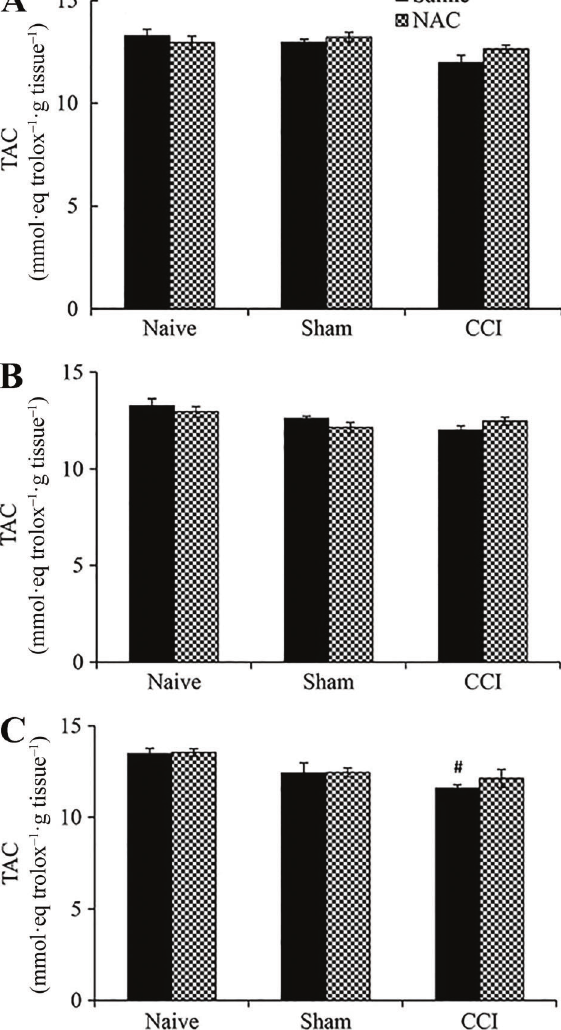
Figure 2. Ascorbic acid levels in the spinal cord of chronic constriction injury (CCI) rats treated with N-acetylcysteine (NAC; 150 mg (cid:1) kg – 1 (cid:1) day – 1 ) or saline administered intraperitoneally for 1 ( A ), 3 ( B ), and 7 ( C ) days (n=6 animals/group). In Sham rats, all surgical procedures involved in the CCI were used except the ligature. Data are reported as means ± SE. *P o 0.05, Signi fi cant difference compared to other groups. (three-way ANOVA followed by Tukey post hoc test).